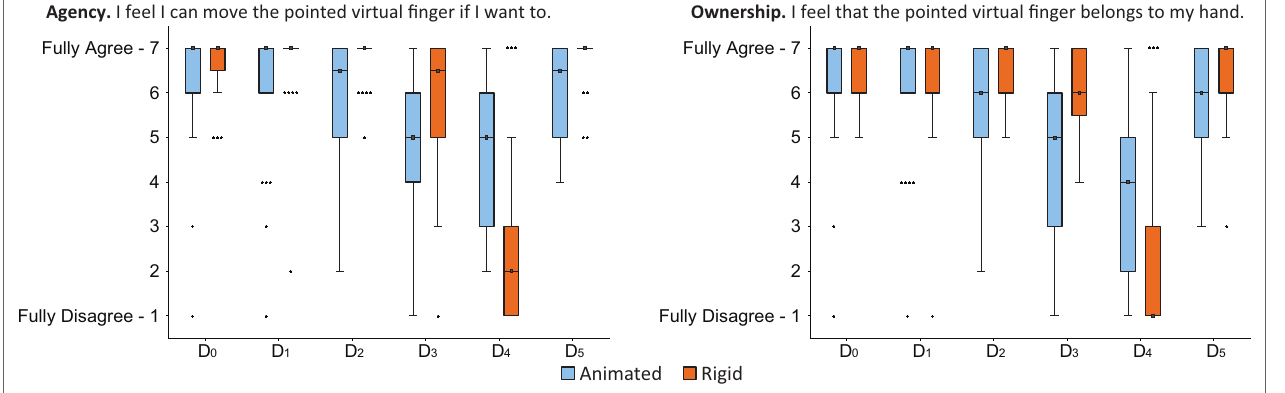
FigUre 5 | interaction effects between group and Digit for the agency and ownership ratings . Results are averaged over both tasks as no main or interaction effects of Task were found.